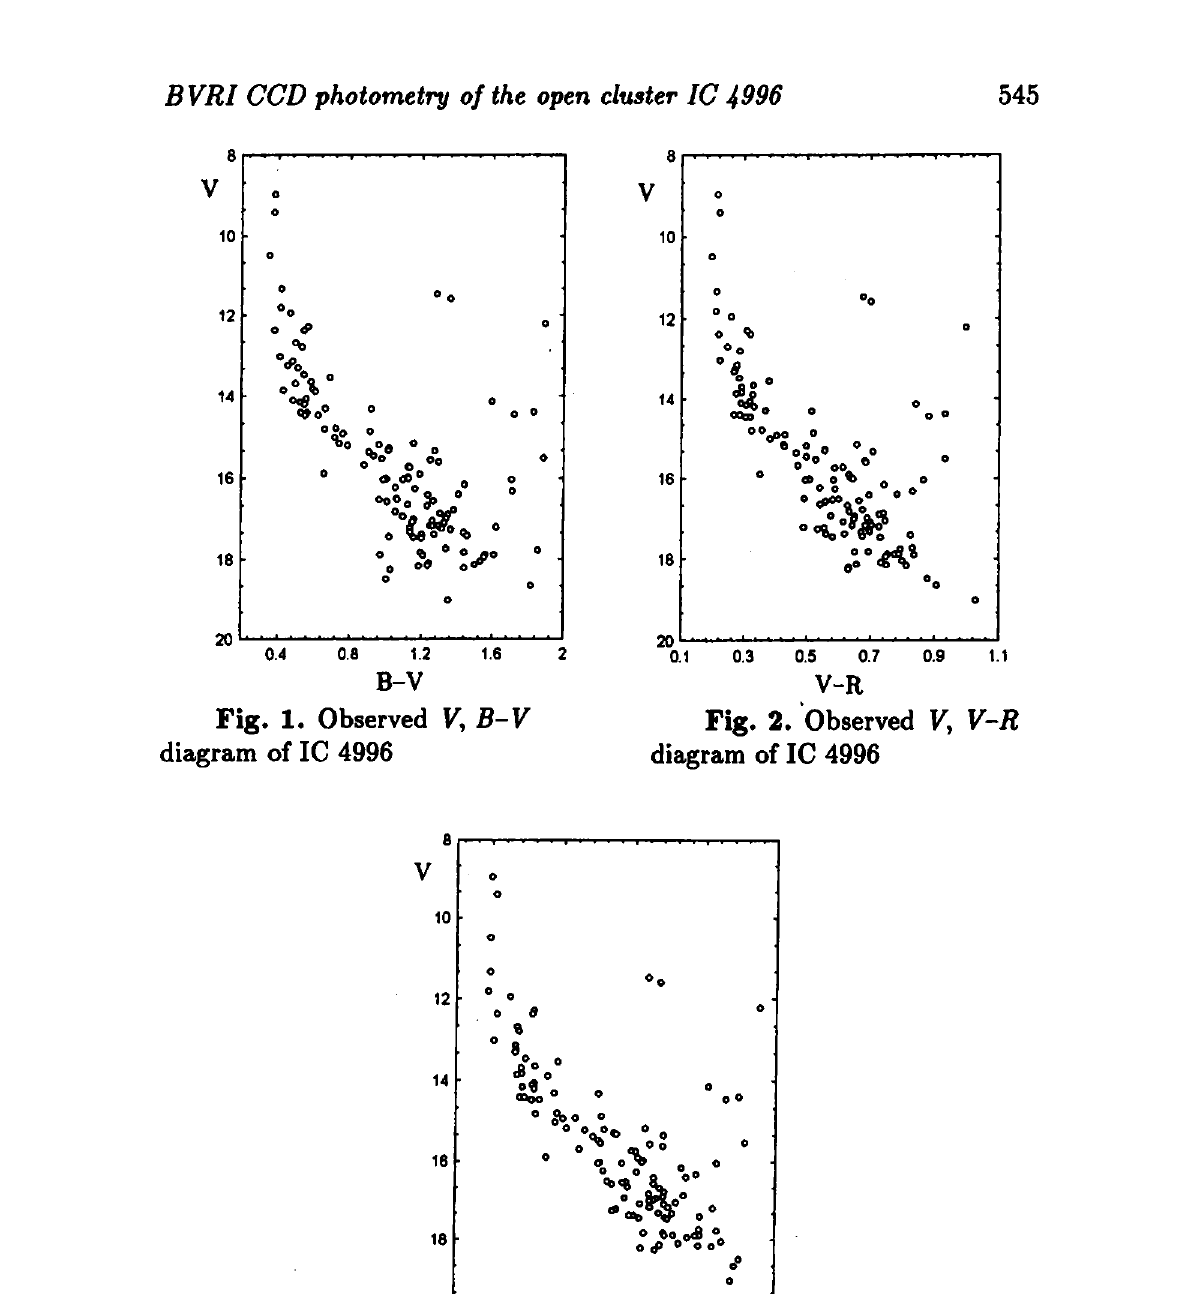
Fig. 3. Observed V, V-I diagram of IC